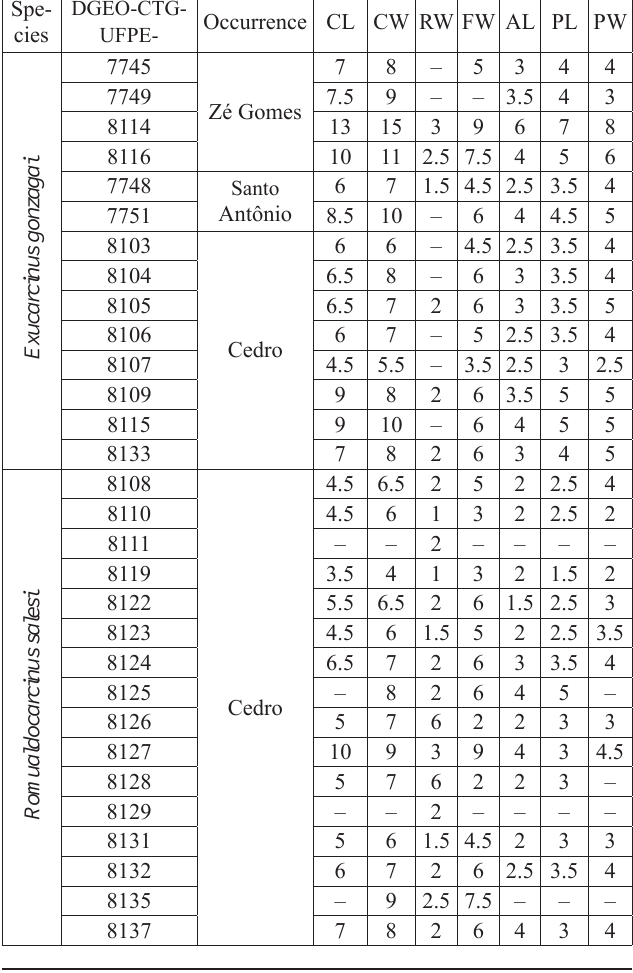
Fig. 3. Orithopsid brachyuran Exucarcinus gonzagai Prado and Luque gen. et sp. nov. from the upper Aptian–lower Albian Romualdo Formation of the Santana Group, Araripe Basin, Pernambuco, Brazil. A . Holotype DGEO-CTG-UFPE-8114; A 1 , SEM image of dorsal carapace; A 2 , negative colour image of A 1 ; A 3 , close-up of right orbit, orbital fissures, and outer